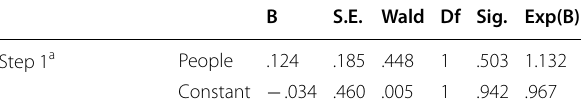
Table L: Variables in the equation for people orientation culture